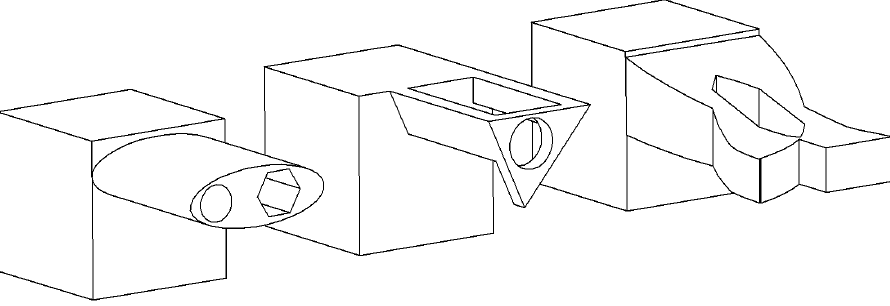
Figure 5. Examples of overhanding and protruding part features.